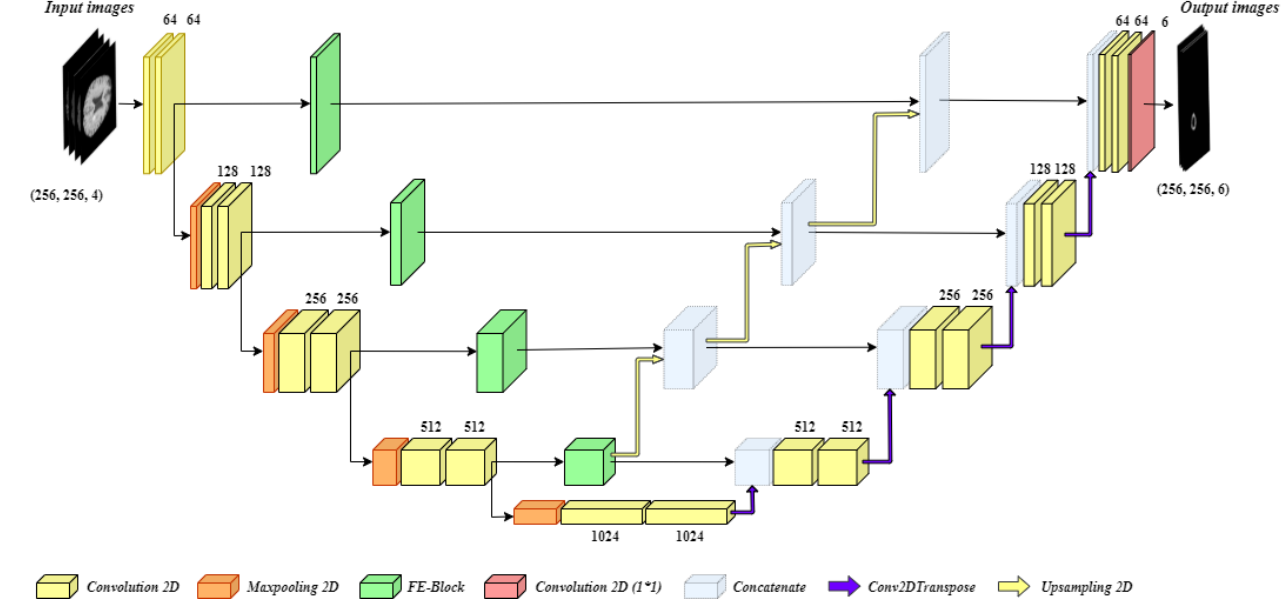
Figure 2. Architecture of the proposed BrainSeg-Net for MRI brain image segmentation. As can be seen in Figure 2, the proposed BrainSeg-Net architecture is an encoder– decoder-based technique. The left side of the figure shows the encoder, which is a contract- ing path, while the right side of the figure shows the decoder, which is an expanding path. The input preprocessed image is of size 256 × 256 where there are four input channels. The encoder and decoder have four blocks with a single transition at bottom of the archi- tecture. Every block of the encoder side consists of two convolution layers while three of the blocks also carry single max-pooling layer. The blocks of decoder consist of a dropout layer and two convolution layers, while the last decoder block contains an additional convolution layer with the filter size of 1 × 1. The transition block contains a max-pooling layer along with two convolution layers. The output of every encoder block is given to the next encoder block and the FE block. The output of the last block of the encoder is given to transition block while its output is given to the first decoder block. The sequence of decoder blocks starts from the bottom, while the output is taken from the last block of the decoder. The output of every decoder block undergoes Conv2DTranspose. A bridge connection between between every encoder block and its associated decoder block contains FE block. The output of the FE block is concatenated with the output of all the deeper stage FE blocks. Finally, the generated output is concatenated with the output of corresponding Conv2DTranspose layer of the decoder block and dropout is applied on the result, followed by convolution process carried out by two convolution layers of the decoder block. The information collected by deeper FE blocks is upgraded and is shared with all available higher level decoder blocks. The upsampling operations performed in BrainSeg- Net are done using bilinear interpolation. The convolution layers used in BrainSeg-Net perform convolution with padding which allows achieving similar-sized output as of input. While the baseline architecture does not have this characteristic. The dropout ratio in BrainSeg-Net is kept at 0.3. All convolution layers of BrainSeg-Net contains Batch normalization and Rectified Linear Unit (ReLU) activation function excluding the